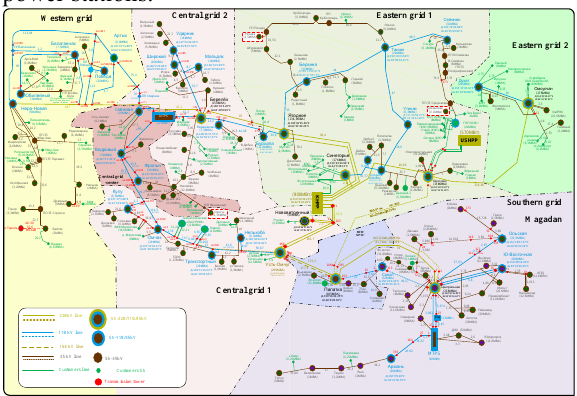
Fig. 1. Power system under consideration.